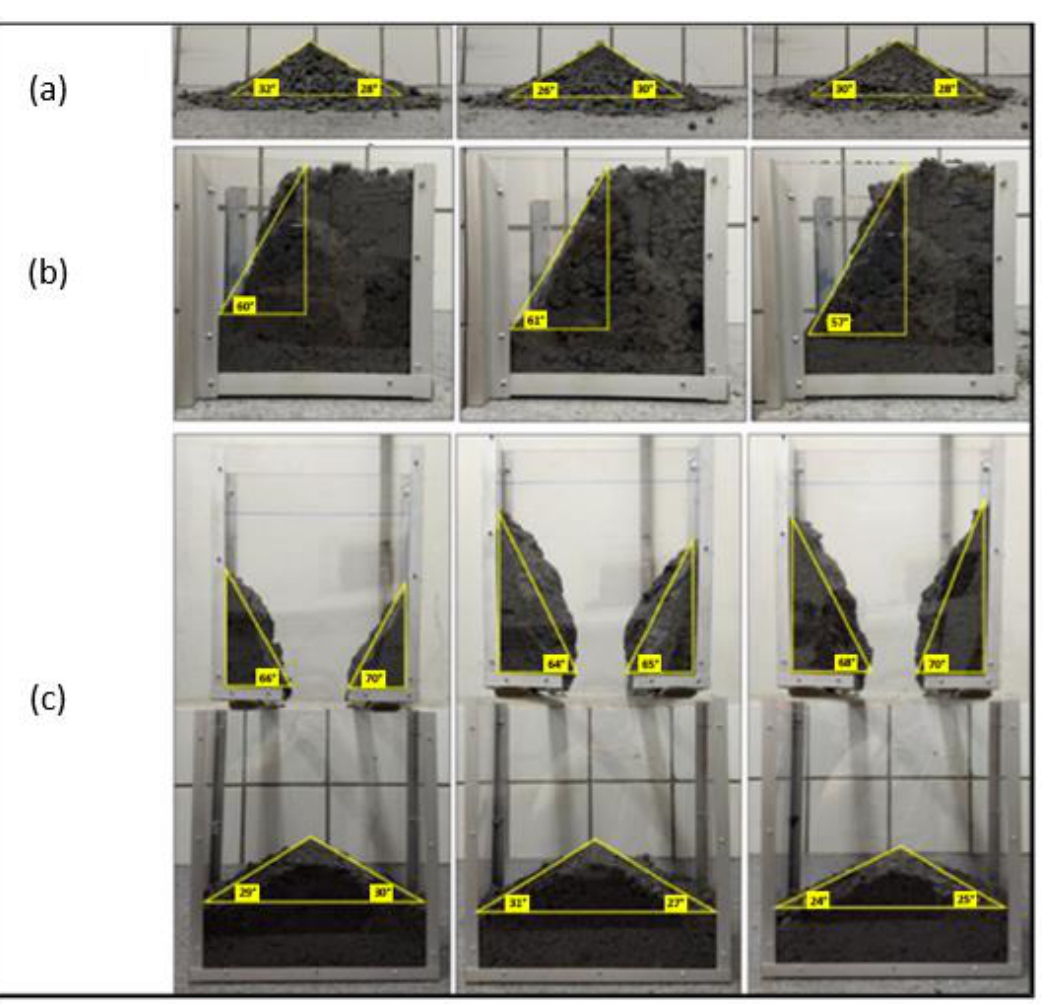
Figure 4. ( a ) Lifting cylinder test, ( b ) Shear box test, and ( c ) Draw down test. Table 3. Summary of Laboratory test results.